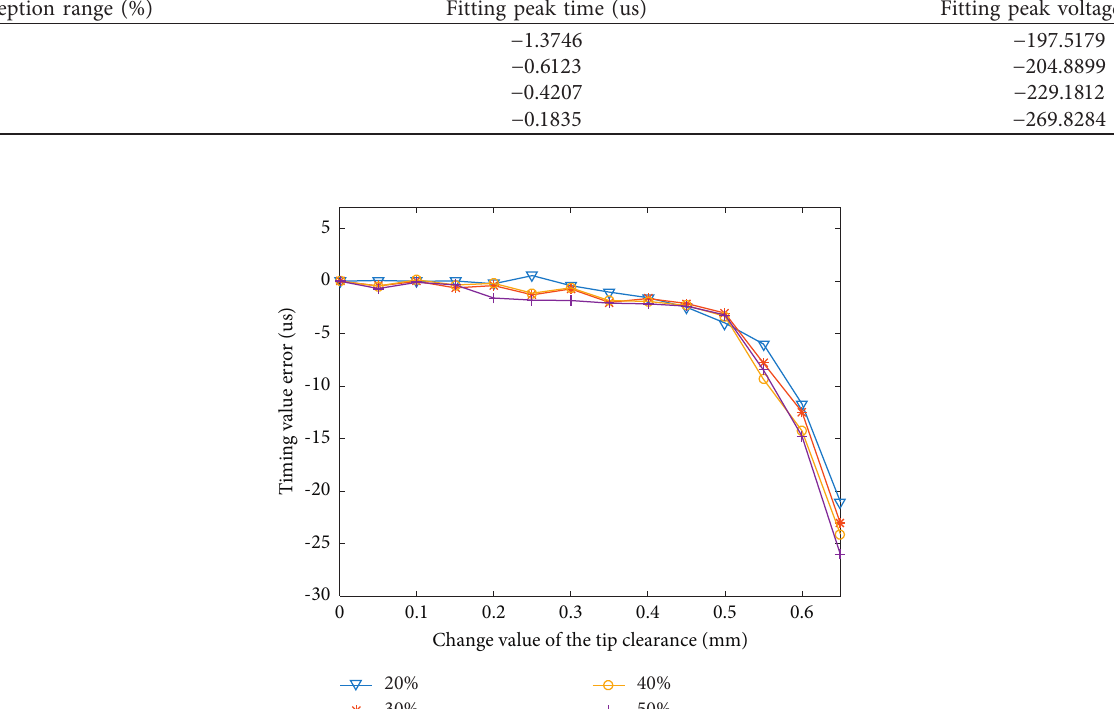
Table 1: Quadratic fitting results of different interception ranges of the pulse signal. Interception range (%) Fitting peak time